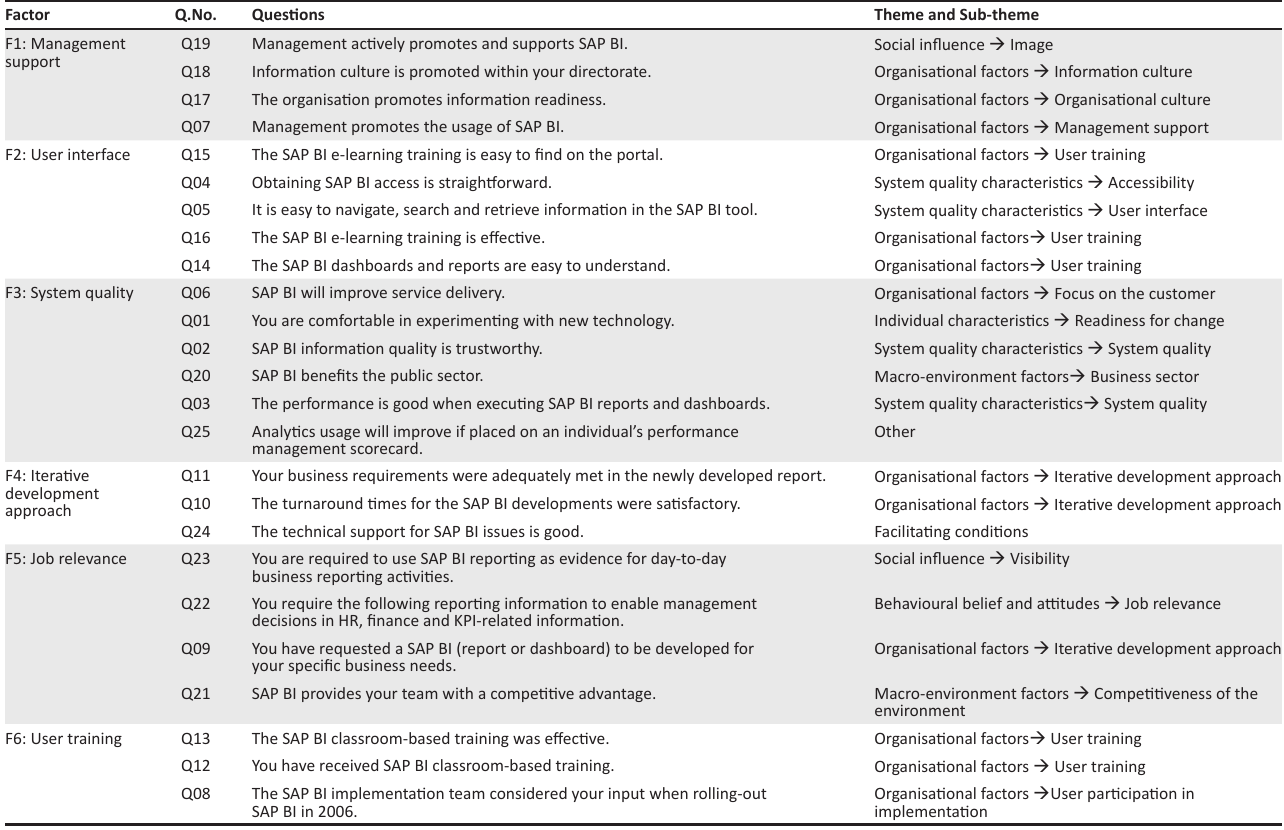
TABLE 2: Themes and sub-themes breakdown per factor. Factor